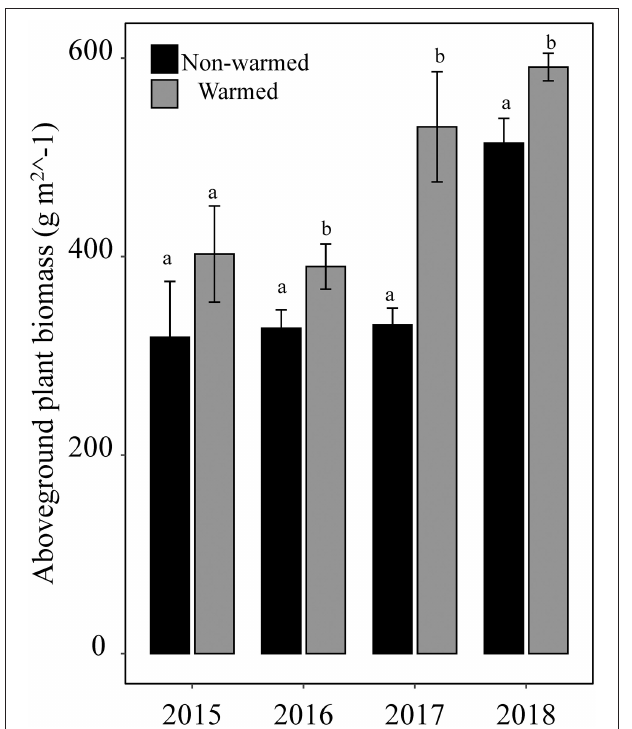
FIGURE 1 | Aboveground biomass in both non-warmed and warmed chambers from 2015 to 2018. Different letters indicate a significant difference ( P < 0.05) between warmed and non-warmed chambers for each experimental year.